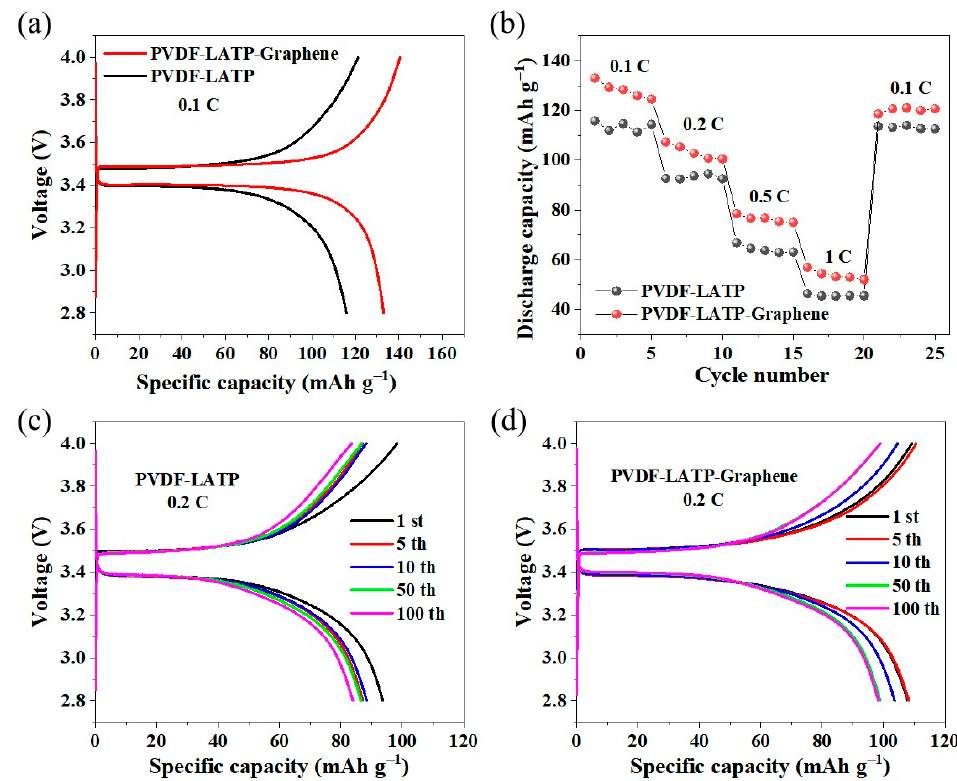
Figure 6. ( a ) First charge–discharge curves of LFP/PLL/Li and LFP/PLLG/Li at 0.1 C, ( b ) rate capability of LFP/PLL/Li and LFP/PLLG/Li, charge–discharge curves of ( c ) LFP/PLL/Li and ( d ) LFP/PLLG/Li at the 1st, 5th, 10th, 50th and 100th cycles at 0.2 C.